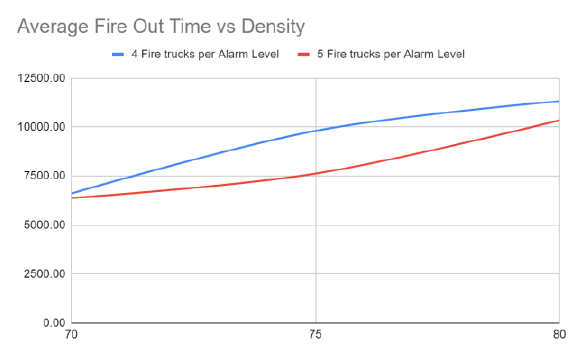
Figure 8 . Graph of fire out times at 70-80% density with increased fire truck responses.